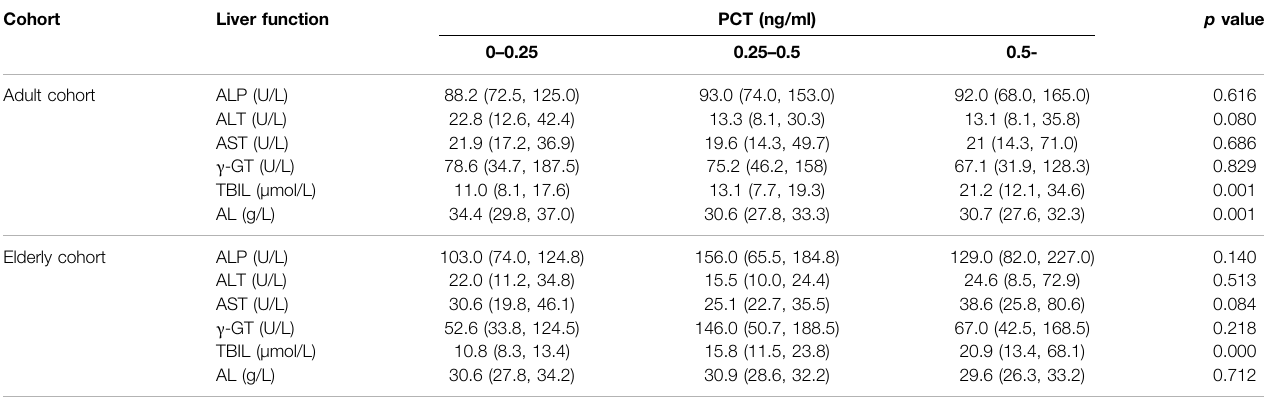
TABLE 4 | Comparisons of liver function under different in fl ammation degrees as re fl ected by PCT levels in the two cohorts.